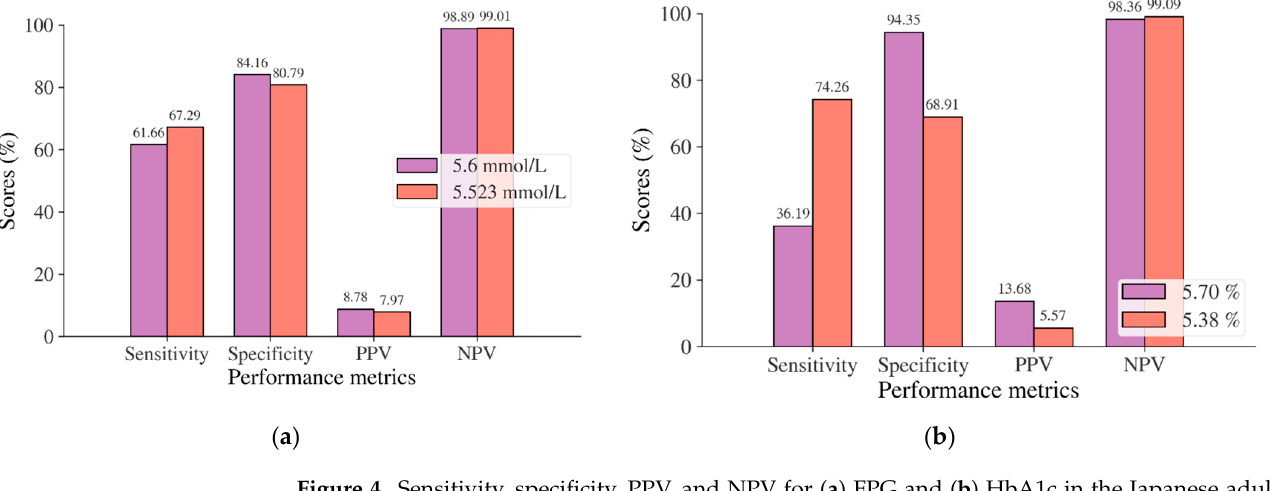
Figure 4. Sensitivity, specificity, PPV, and NPV for ( a ) FPG and ( b ) HbA1c in the Japanese adult population based on ADA and WHO cut point recommendations compared to the optimal cut point.